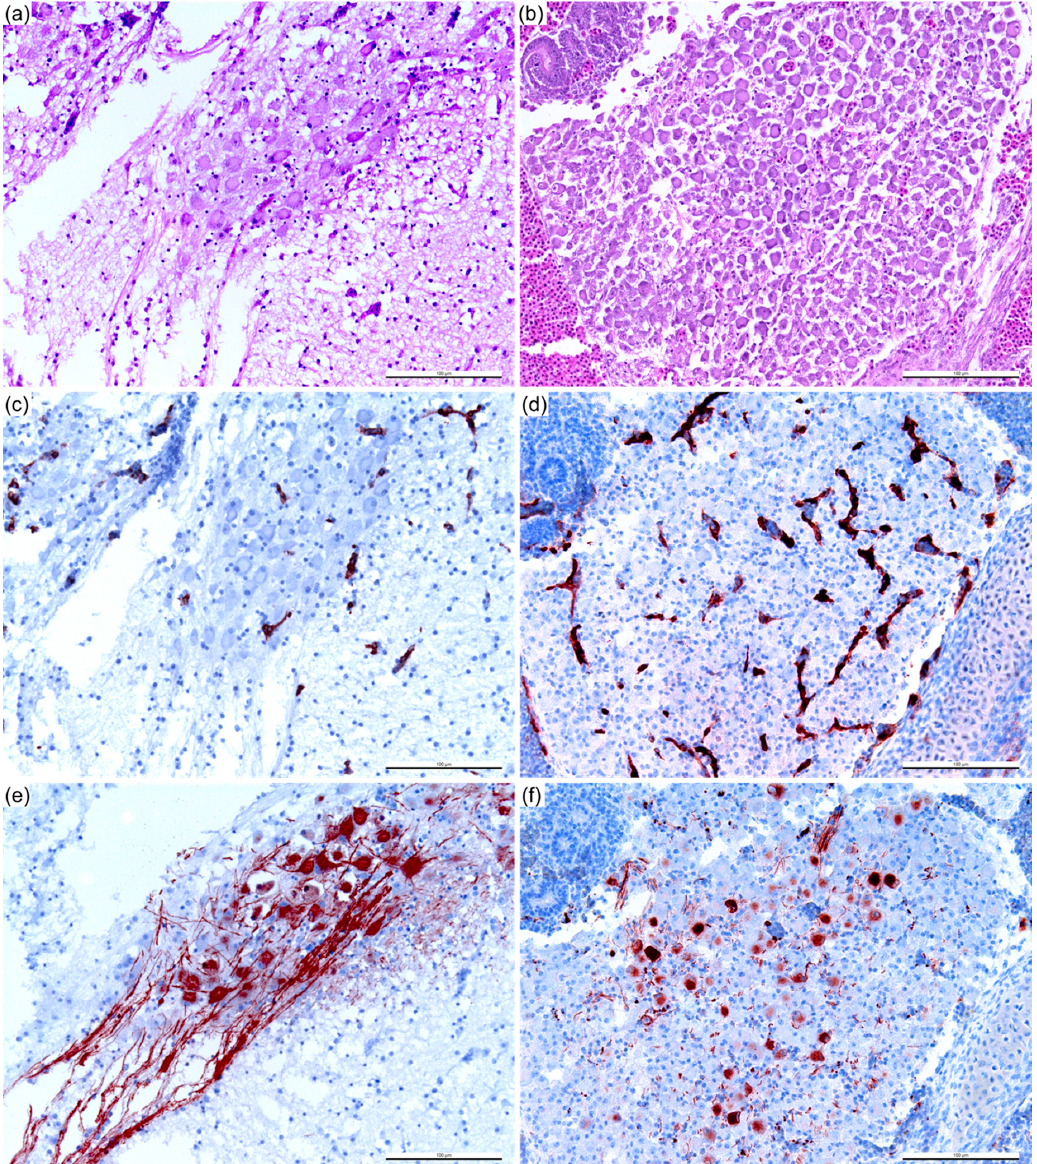
Figure 6. Neuronal and vascular replication of BTV within cerebrum ( a , c , e ) and dorsal root ganglion ( b , d , f ). Serial sections of the cerebrum ( a , c , e ) and dorsal root ganglion ( b , d , f ) were stained with hematoxylin and eosin (H&E) ( a , b ) and immunohistochemistry (IHC) for NS2 ( c , d ) and NS1 ( e , f ), showing NS2 antigens within vascular endothelial cells ( c , d ) and NS1 antigens within the neuronal cells ( e , f ) of the cerebrum and dorsal root ganglion, respectively. Vascular localization of NS2 antigens was similar to that of NS3/3a and viral protein 7 (VP7) (not included in the panel). Scale bar = 100 μ m.